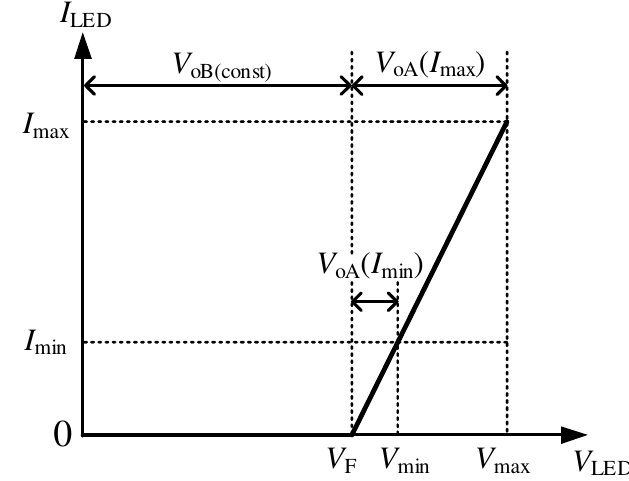
Figure 2. Output ranges of the converters with the conventional